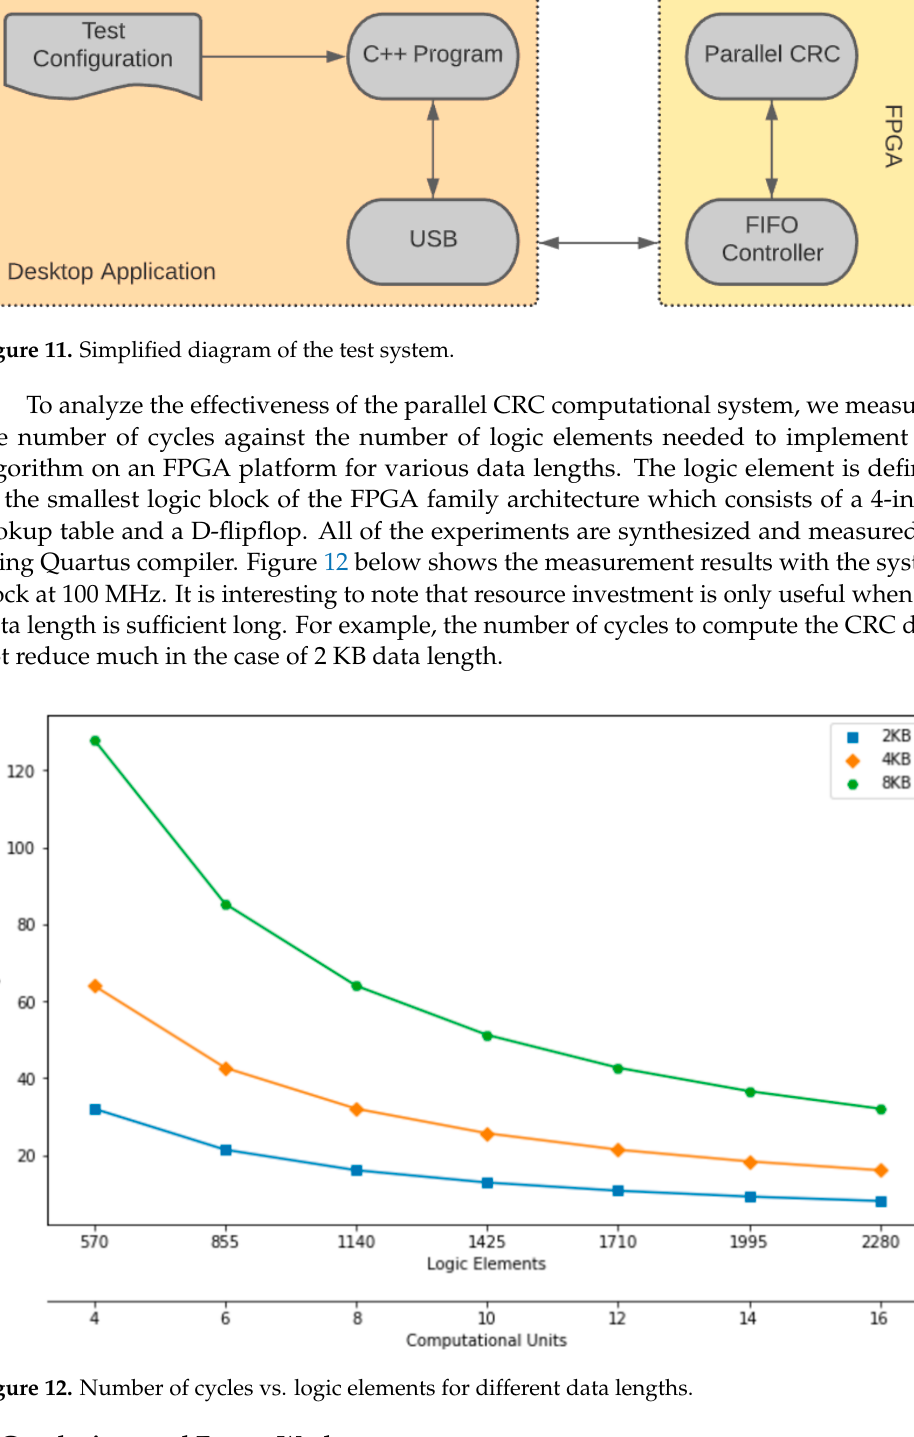
10 of 12 Figure 10. Measured normalized operating time vs. threads for 2 MB data .